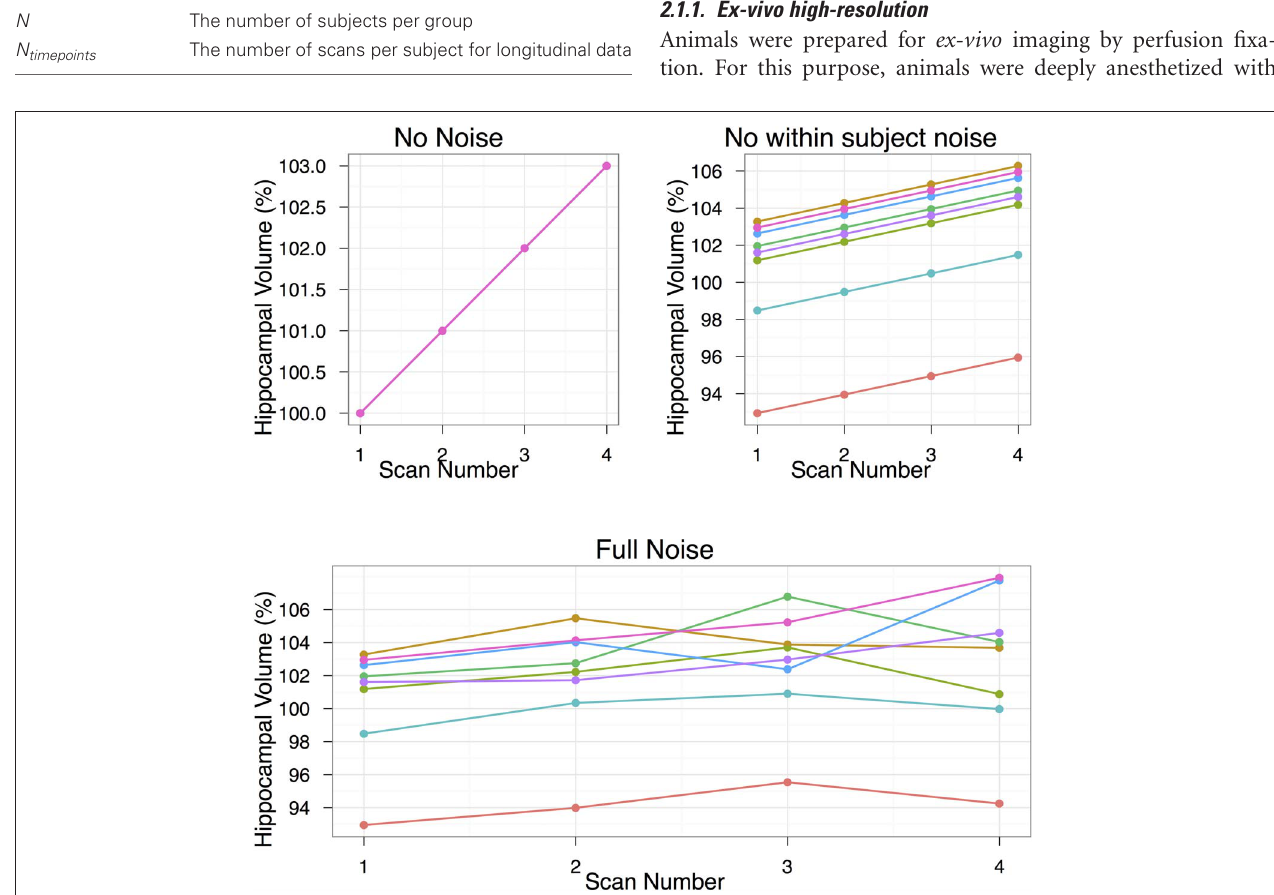
FIGURE 1 | The data simulation, shown under three conditions of no noise, only population noise, and both population and subject noise. The population noise is representative of biological variability. Subject noise includes a combination of factors including imaging method and registration algorithm noise that affects the ability to produce the same result on